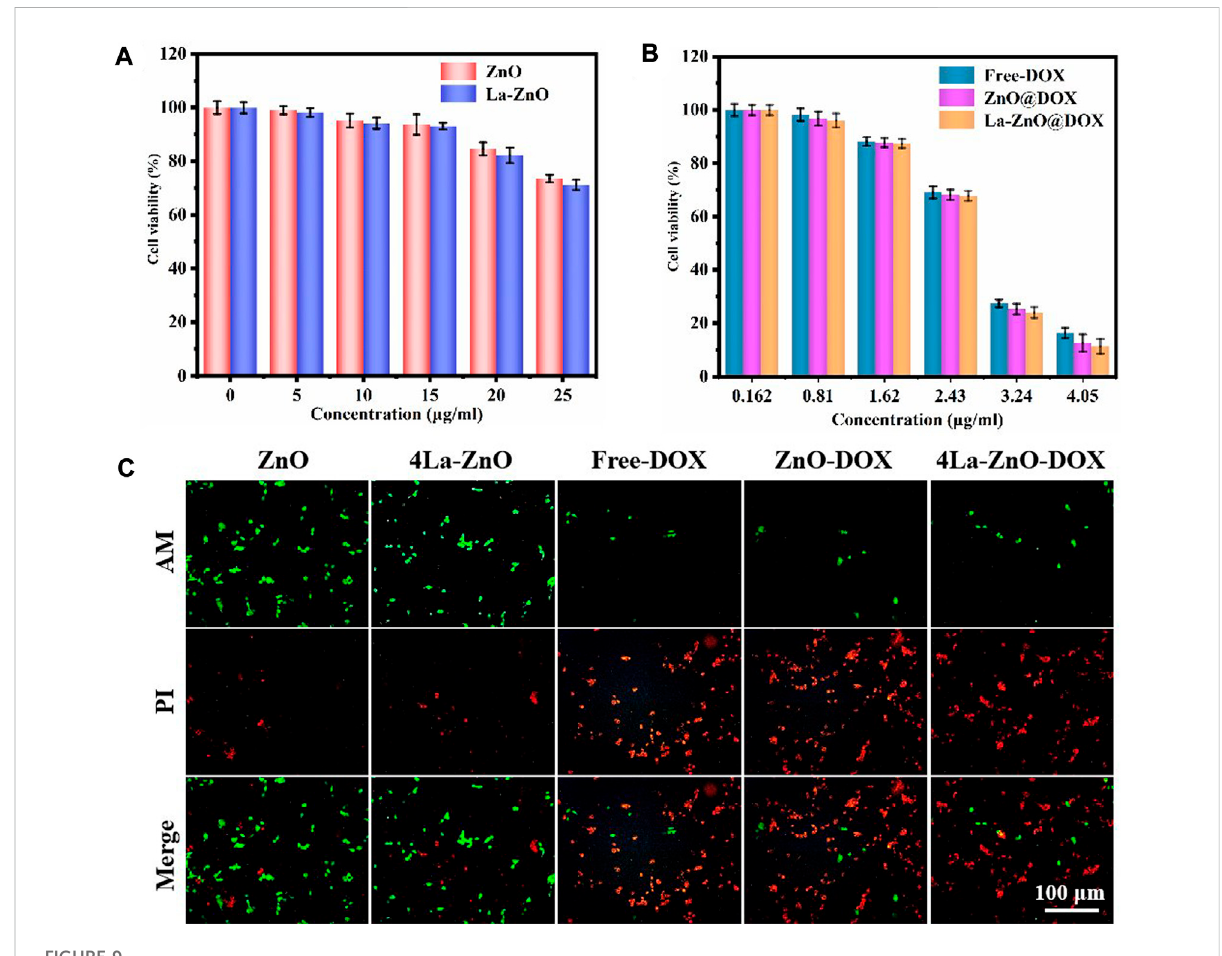
FIGURE 9 Cytotoxicity study of B16 cells after 48 h of incubation with (A) ZnO QDs and La-ZnO QDs. (B) Free-DOX, ZnO@DOX and 4La-ZnO@DOX. (C) The fl uorescent images of the cells treated with different groups and stained with